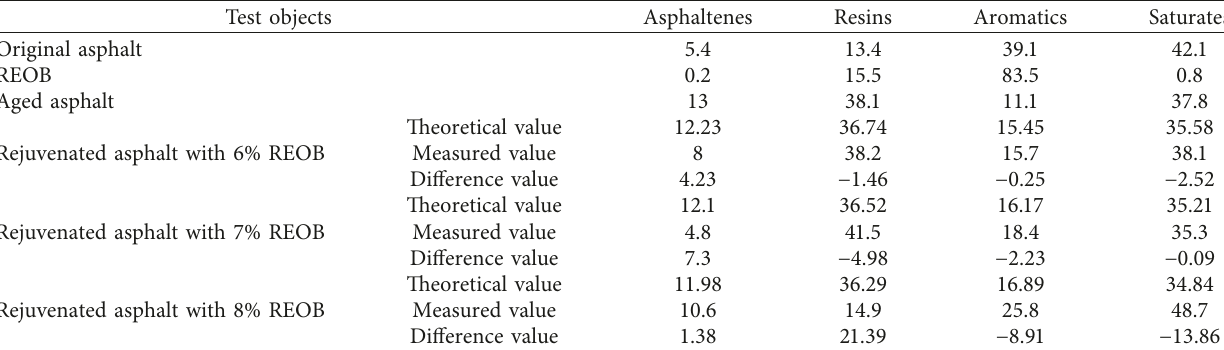
Table 4: Content of four components of REOB and different asphalt binders